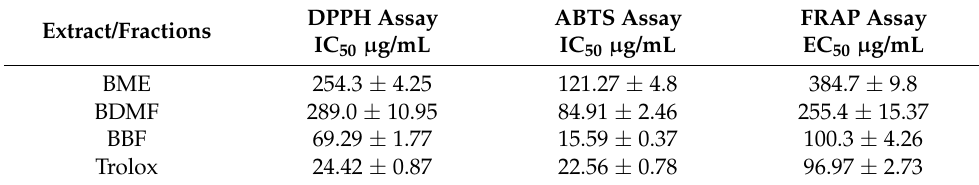
Table 2. Antioxidant activity of BME, BDMF, and BBF by DPPH, ABTS, and FRAP assays. Extract/Fractions